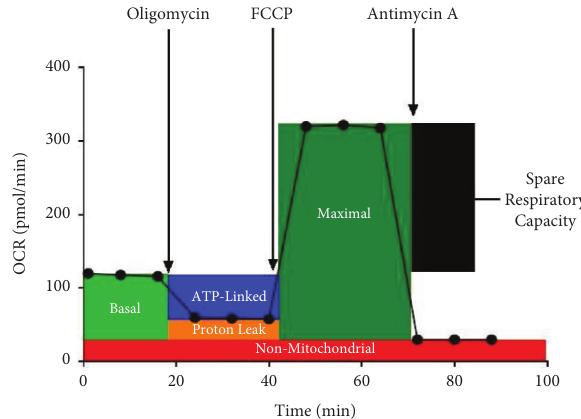
Figure 1: Schematic description of the Seahorse analysis. FCCP � carbonyl cyanide-4-phenyl-hydrazone; OCR � oxygen consumption